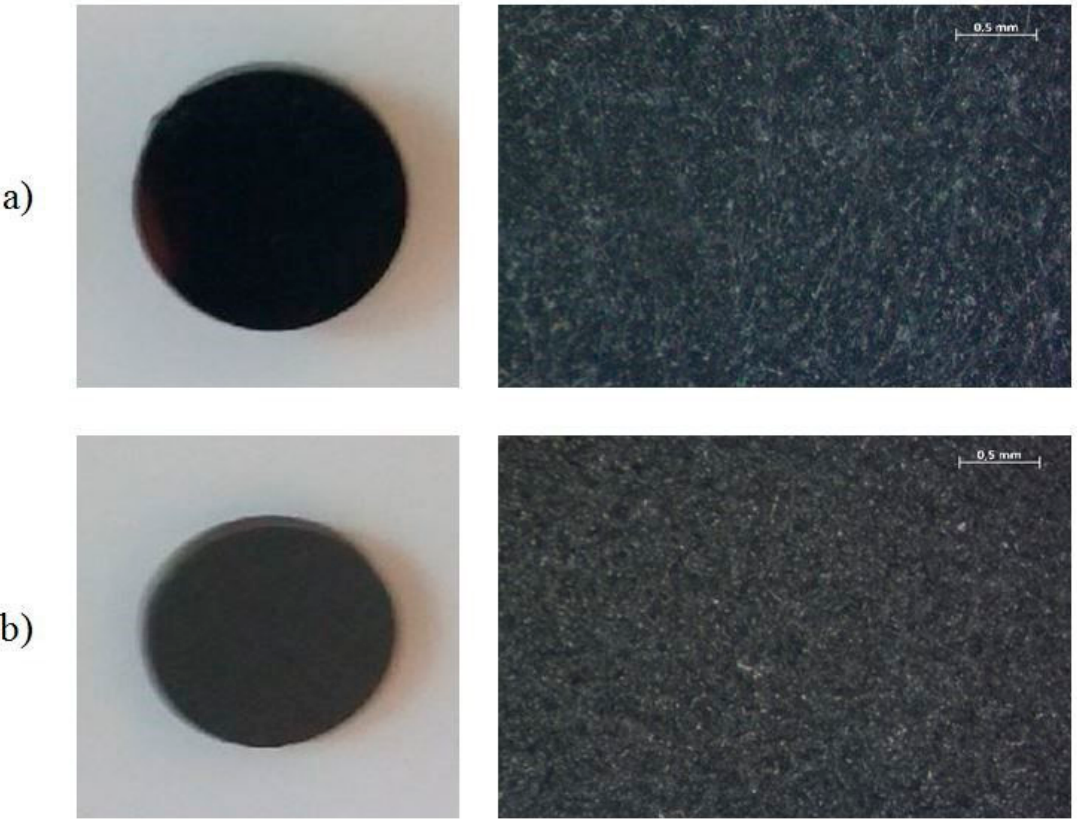
Figure 2. Sample surface: ( a ) polished, ( b ) subject to treatment by abrasive blasting with sand with a grit of 50 µ m, with diamond like carbon (DLC) coating.